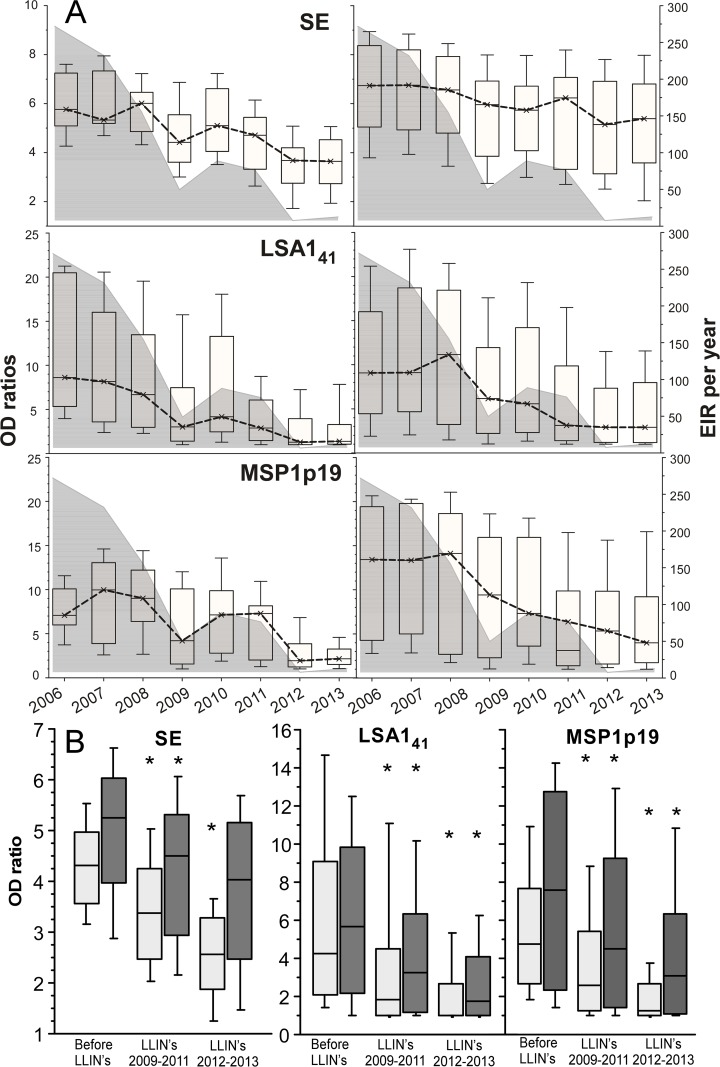
Temporal distribution of entomological inoculation rate and antibody levels to three P. falciparum antigens in two age groups from Dielmo during the 2006–2013 period.The entomological inoculation rate (EIR, the mean number of infected mosquito bites per person per year) is shown for the12 month-period extended from July1st till June 30th of the following year. In part (A), the antibody levels against SE, LSA141 and MSP1p19 are shown as box-and-whisker plots of the OD ratios (left y axis) each year from 2006 to 2013 for young individuals (left part) and older individuals (right part). The box shows the first to the third quartile range, the band inside represents the median value; the limits of the whiskers represent the 95% percentiles. The temporal evolution of the median is shown by the dotted line. The temporal evolution of the EIR (right y Axis) is plotted as the background grey area. In part (B) antibody responses are summarized as box-and-whisker plots (as above) by age group, and before and after LLIN distribution in 2008 and 2011. Asterisks indicate significant different levels for a given age group between two successive time periods (P<10−2, Mann Whitney Test).